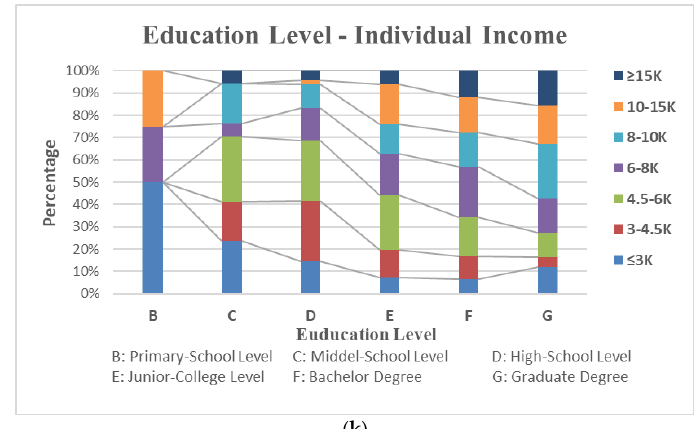
Figure A1. Characteristics of Participants and their Households. ( a ) Sex; (b) Age; ( c ) Individual Monthly Income (RMB); ( d ) Highest Level of Education; ( e ) Job Type; ( f ) Household Income per Year (RMB); ( g ) Number of Driving Licenses in a Household; ( h ) Number of Children in a Household; ( i ) Number of Vehicles Owned by a Household; ( j ) Number of Household Members; ( k ) Relationship